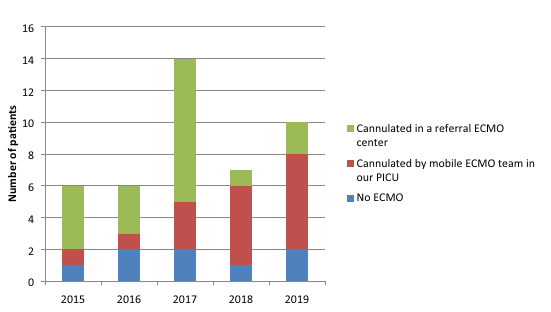
Fig. 1 Number of patients transferred to an ECMO center over time E-posters P‑001 The Use of ICU Resources in Metastatic Breast Cancer Guillaume Beinse 1 , Jean‑Jacques Tudesq 1 , Luis Teixeira 2 , Edith Borcoman 1 ,